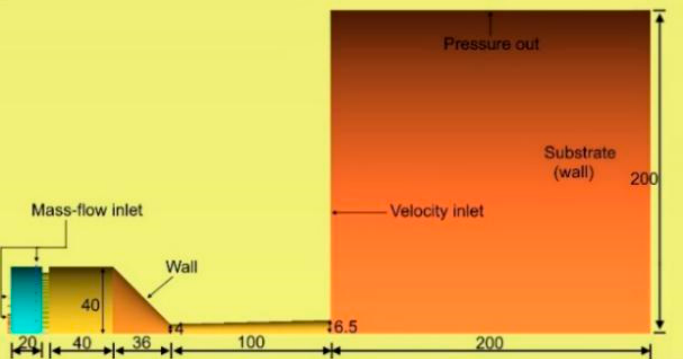
Figure 2. Model size and boundary conditions (unit: mm).